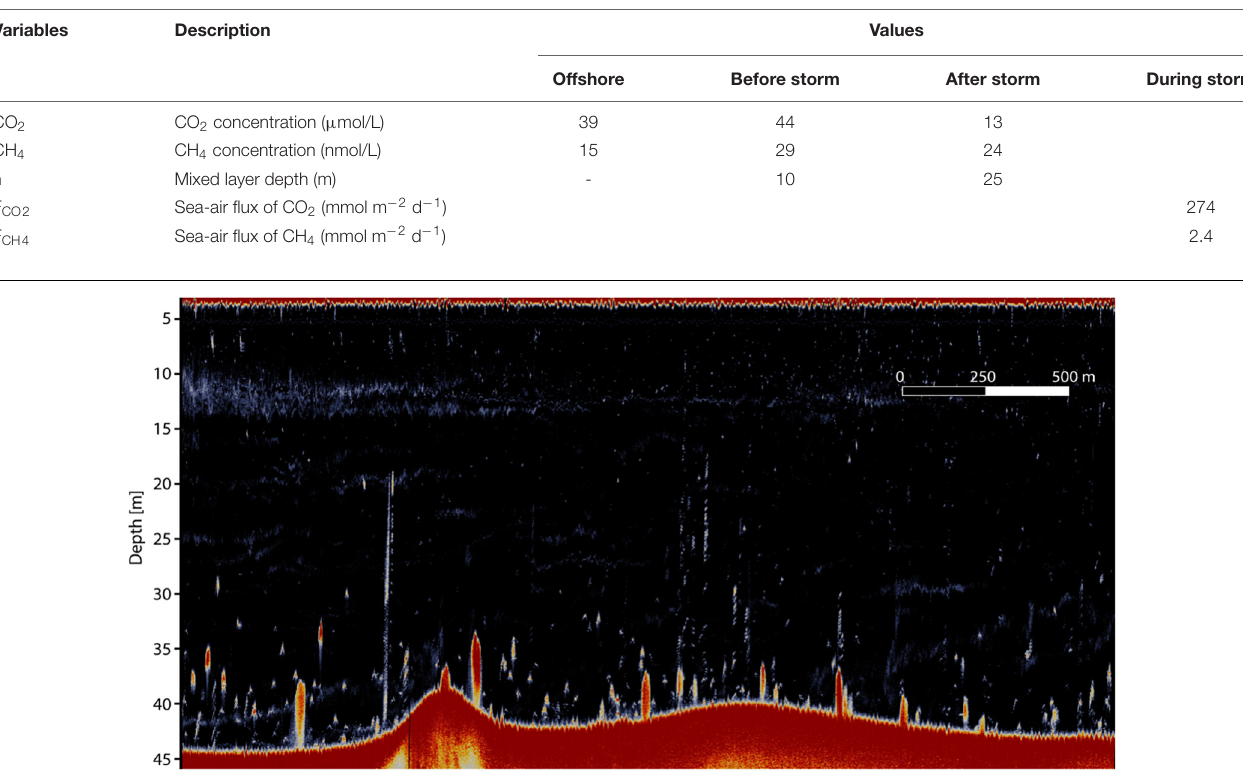
FIGURE 10 | EK80 echogram showing acoustic anomalies associated with gas seeps from the bottom sediments in TZS coastal area (black dashed square in Figure 8A ), following the cruise track from left to right and with color indicating the acoustic target strength (black is < –80 dB and red is > –60 dB). Compass coordinates for the beginning/end of the echogram (23 ◦ 17.4 (cid:48) E, 59 ◦ 49.8 (cid:48) N)/(23 ◦ 16.4 (cid:48) E, 59 ◦ 49.0 (cid:48)